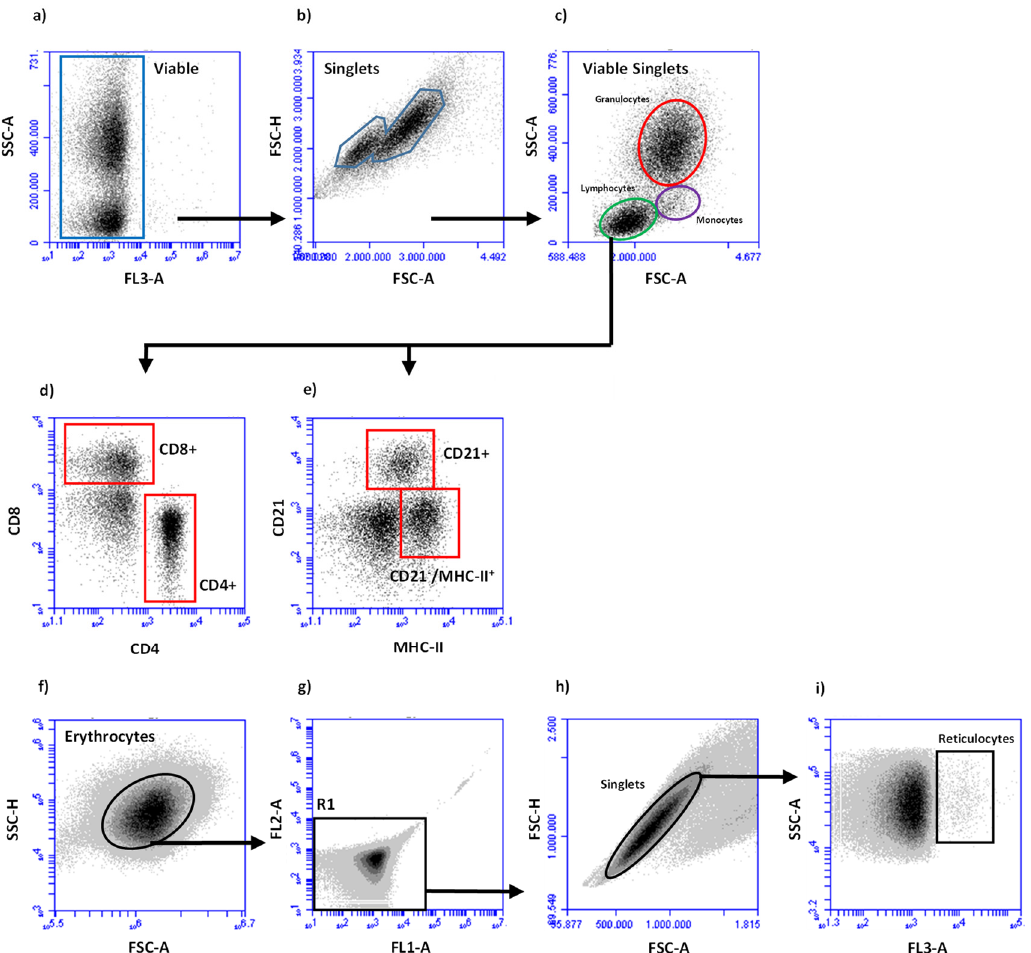
Figure 1. Gating strategy to determine fractions of leucocytes ( a – e ) and reticulocytes ( f – i ). ( a ) Viable, propidium iodide- negative cells were determined in FL3 versus SSC-A density plots.; ( b ) Single cells among viable cells were identified in FSC-A versus FSC-H density plots; ( c ) A region of granulocytes, lymphocytes, and monocytes were identified in FSC-A versus SSC-A density plots. Fractions of lymphoid cell subpopulations were determined after dual staining with antibodies specific for CD4 and CD8 or MHC II and CD21 to identify CD4 + and CD8 + lymphocytes ( d ) or CD21 + B-cells and CD21 − MHC-II + lymphocytes. Erythrocytes were identified in FSC/SSC density plots ( f ) and gated for FL1-/FL2- events (region R1, ( g )). After gating on single cells ( h ), reticulocyte fractions were determined in FL3/SSC density plot ( i ).